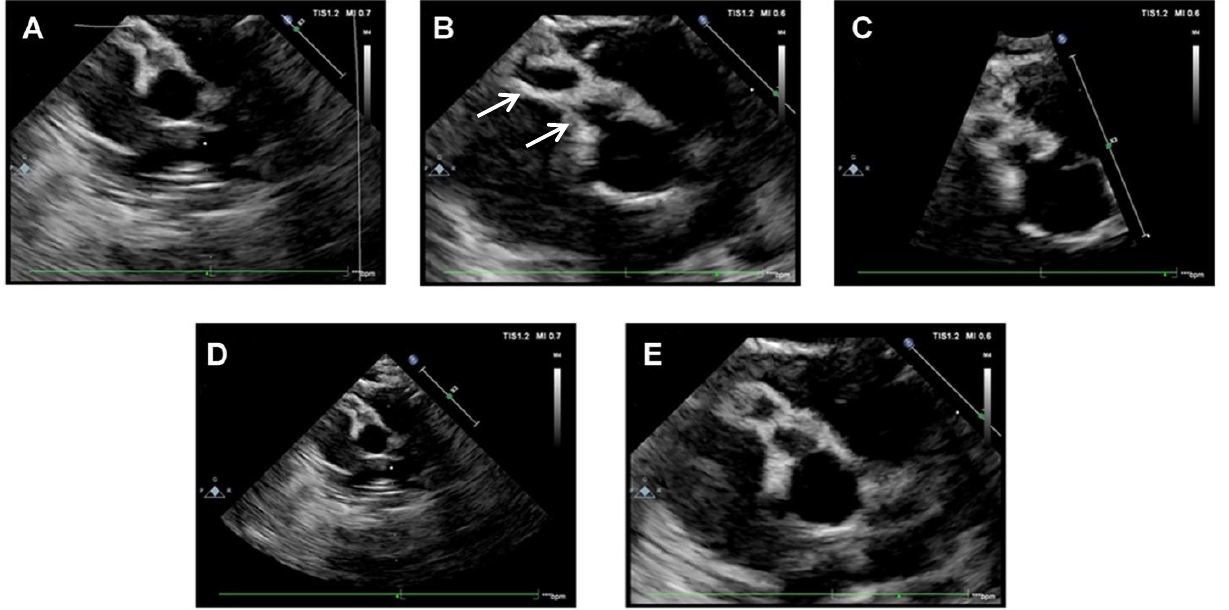
Figure 3. Echocardiographic scans at hospital admission. ( A – D ): medium-size fusiform aneurysms of right CA (beaded appearance). In Figure ( B ), arrows indicated aneurysms of right CA. ( E ): medium-size dilatation of proximal right CA.